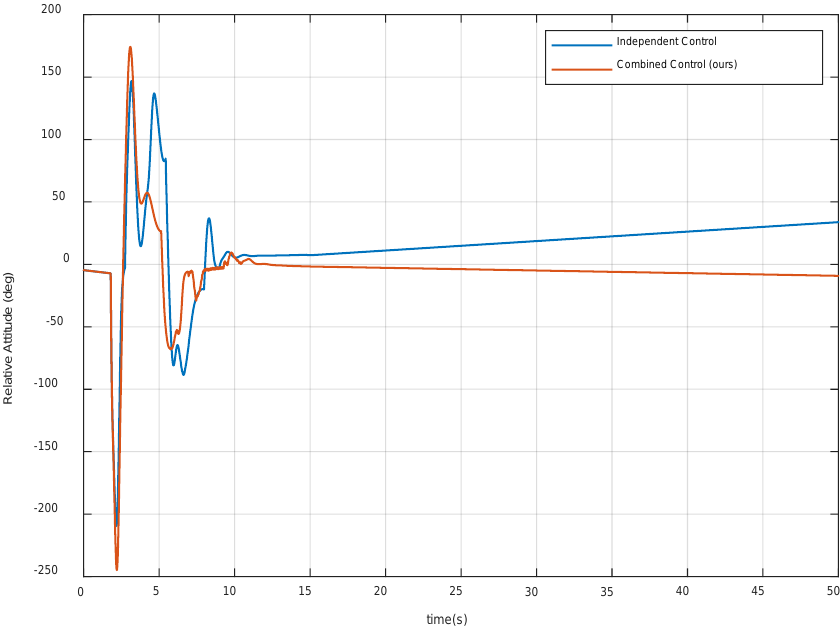
Figure 13. Relative attitude between the contact plane and the target spacecraft surface.